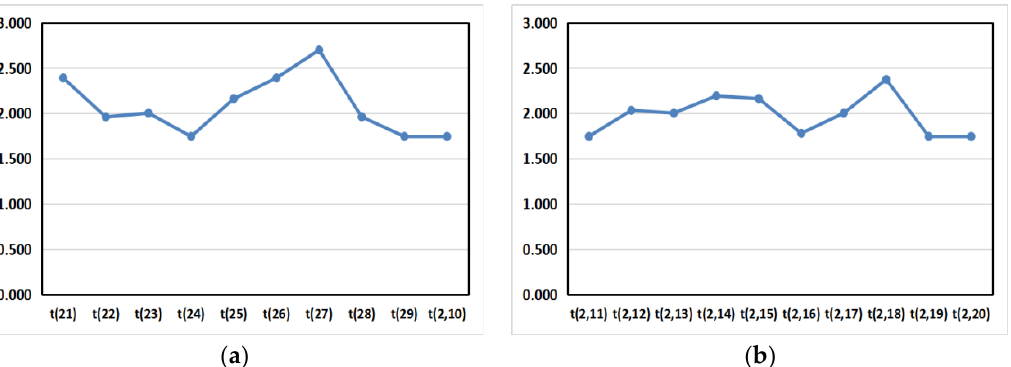
. ( b ) shows the tourist-needs rela-